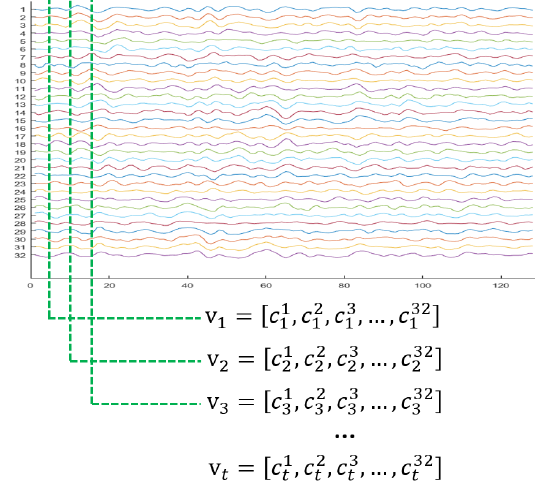
Figure 3. Example of raw 32-channel EEG data from the DEAP